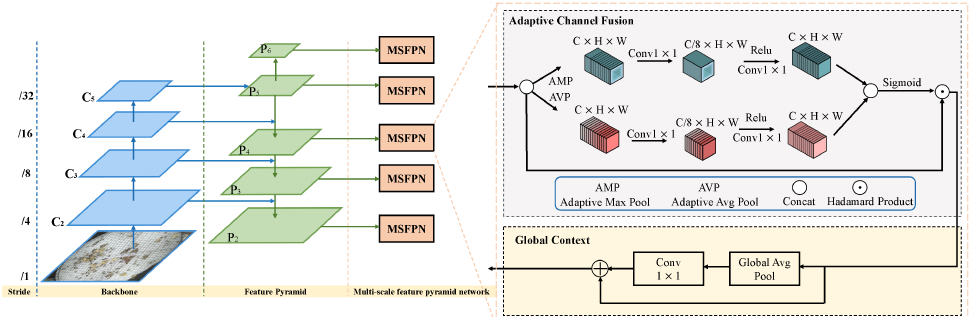
Figure 5. The network architecture of the proposed